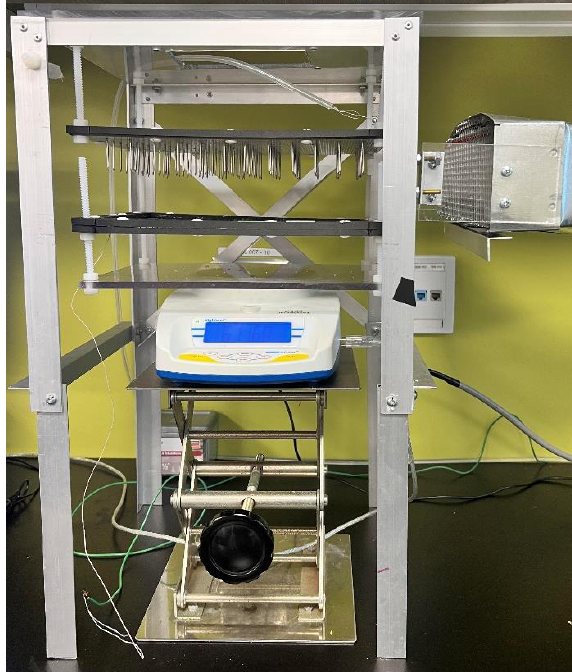
Figure 1. Electrode arrangement in EHD dryer.